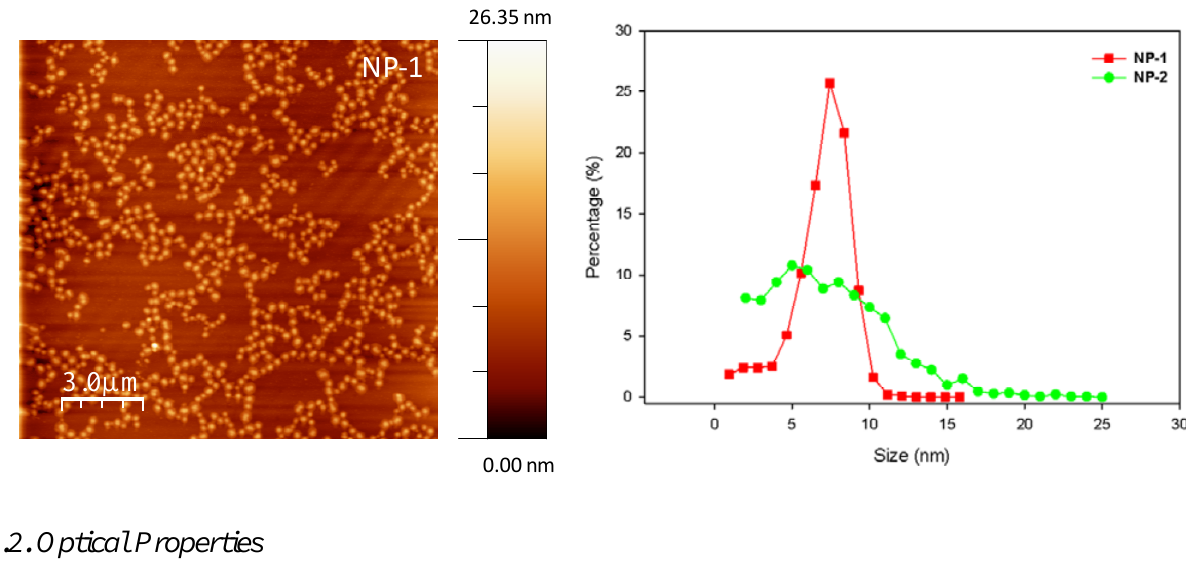
Figure 3. AFM image of NP-1 coated on mica by drop casting from a diluted solution in chlorobenzene ( left ) and the size distribution of the particles determined by their height ( right